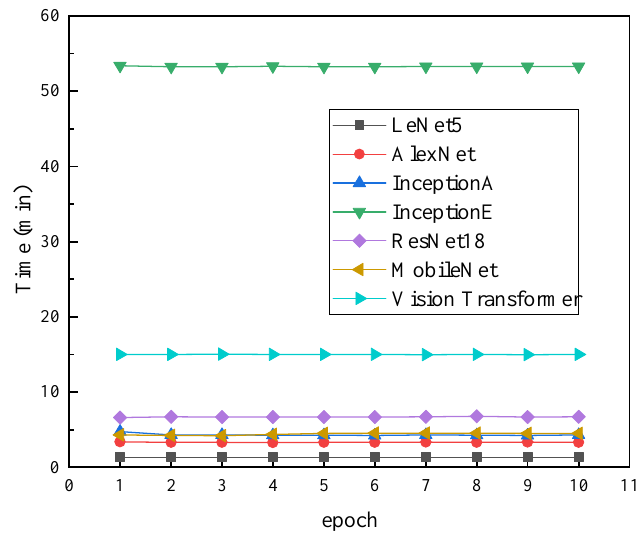
Figure 13. Comparison of computing time of each model.